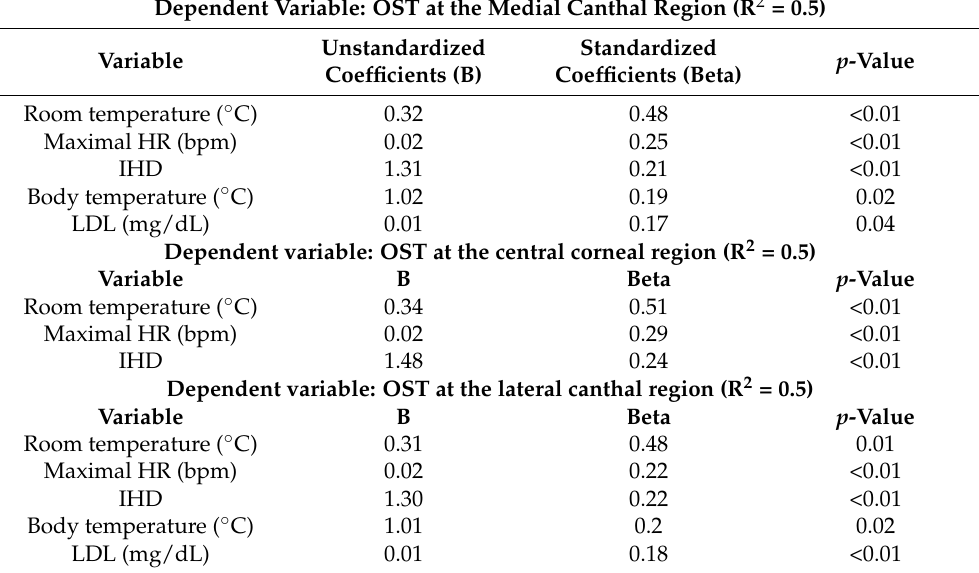
Table 5. The effect of clinical and environmental factors on OST at the different ocular surface regions. Dependent Variable: OST at the Medial Canthal Region (R 2 = 0.5) Unstandardized Standardized p -Value Variable Coefficients (B) Coefficients (Beta) Room temperature ( ◦ C) 0.32 0.48 <0.01 Maximal HR (bpm) 0.02 0.25 <0.01 IHD 1.31 0.21 <0.01 Body temperature ( ◦ C) 1.02 0.19 0.02 LDL (mg/dL) 0.01 0.17 0.04 Dependent variable: OST at the central corneal region (R 2 = 0.5) Variable B Beta p -Value Room temperature ( ◦ C) 0.34 0.51 <0.01 Maximal HR (bpm) 0.02 0.29 <0.01 IHD 1.48 0.24 <0.01 Dependent variable: OST at the lateral canthal region (R 2 = 0.5) Variable B Beta p -Value Room temperature ( ◦ C) 0.31 0.48 0.01 Maximal HR (bpm) 0.02 0.22 <0.01 IHD 1.30 0.22 <0.01 Body temperature ( ◦ C) 1.01 0.2 0.02 LDL (mg/dL) 0.01 0.18